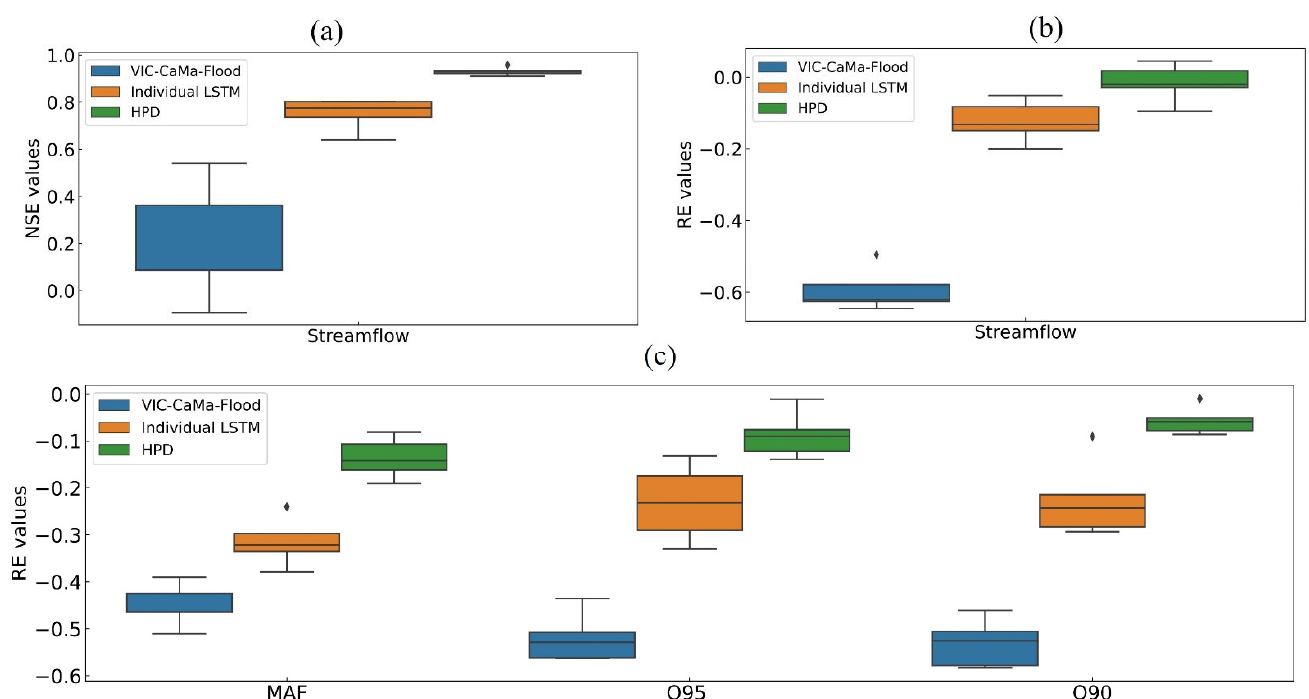
Figure 6. Comparison of simulations from VIC-CaMa-Flood model, individual LSTM model, and HPD model for testing period (1998–2007): ( a ) Distribution of NSE across all stations for daily mean streamflow; ( b ) distribution of RE across all stations for daily mean streamflow; ( c ) distribution of RE for three flood indicators.